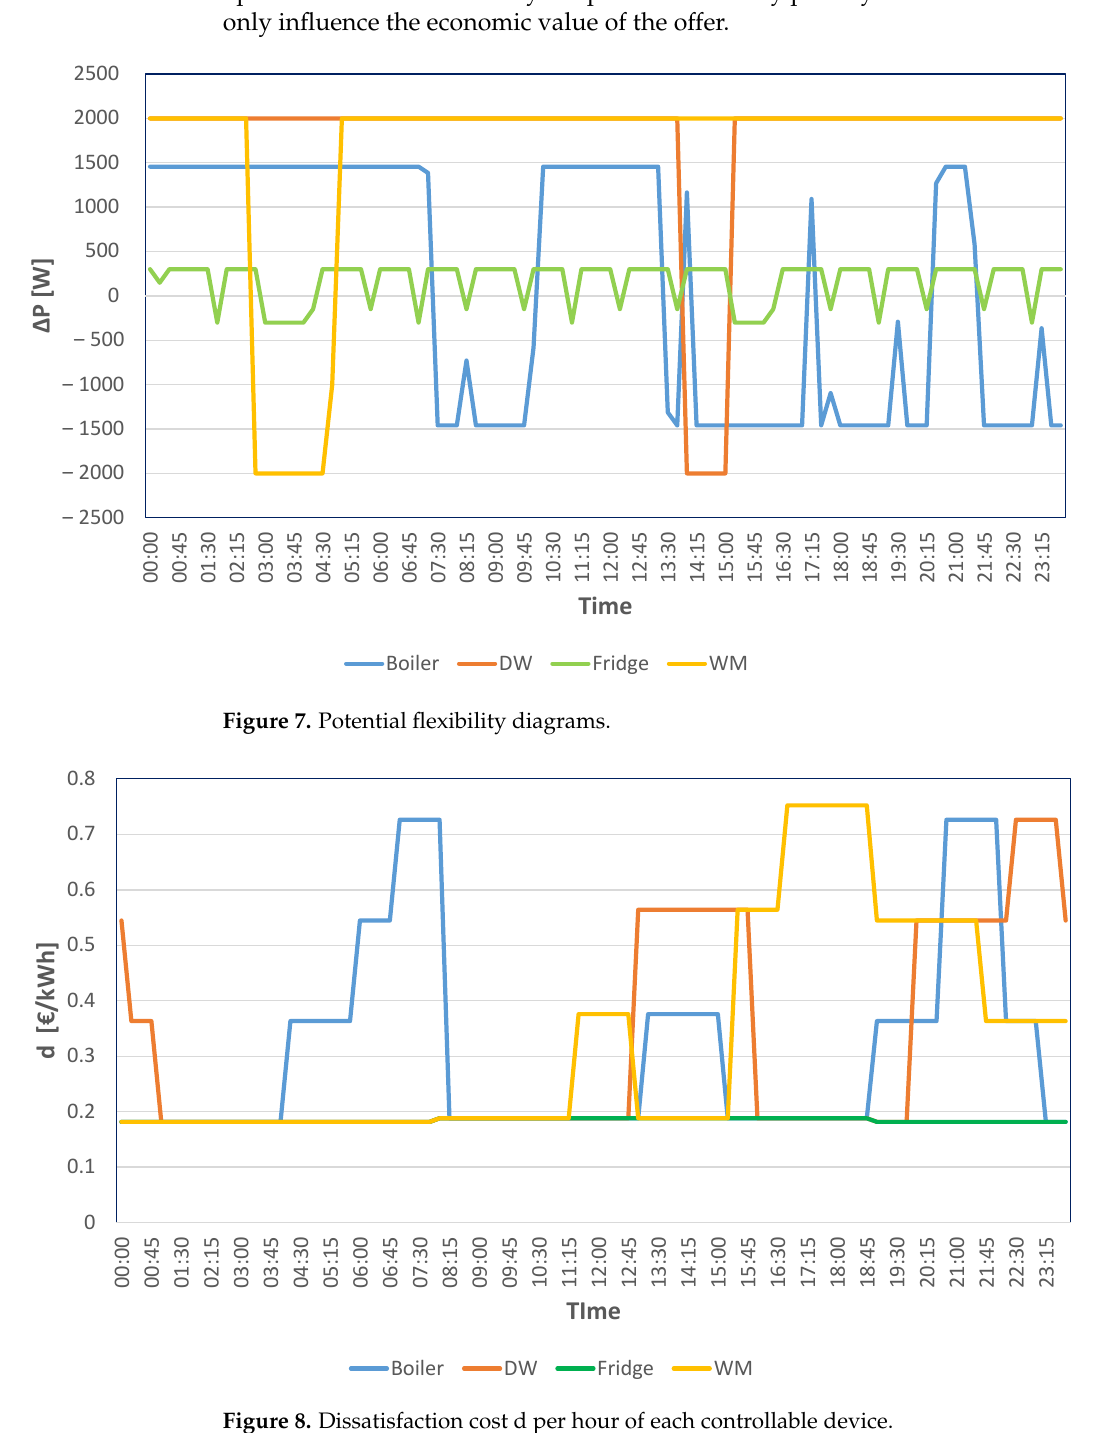
Figure 8. Dissatisfaction cost d per hour of each controllable device.